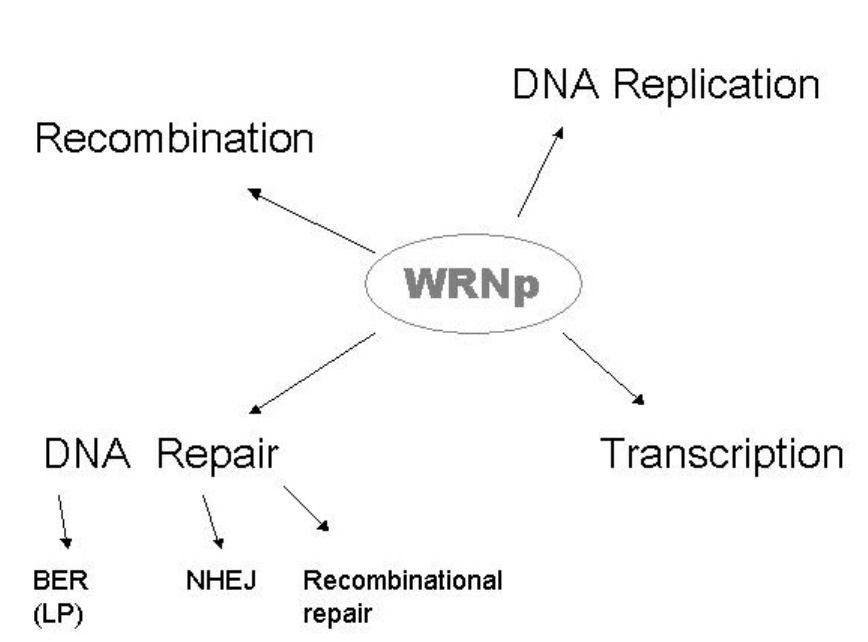
FIGURE 2. Processes in which Werner protein